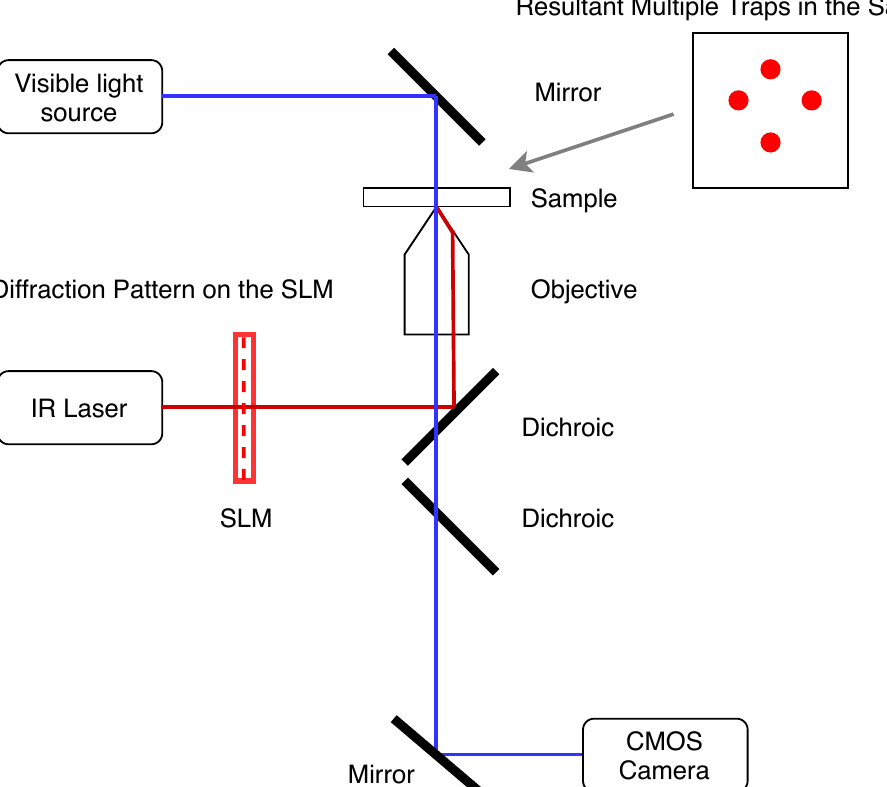
Figure 6. Simple schematic of holographic optical tweezers, based on the authors’ laboratory